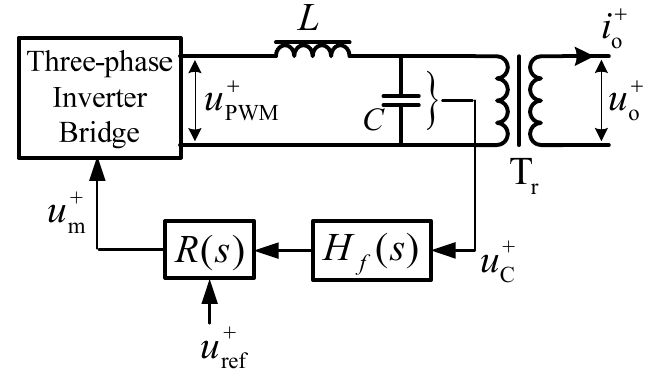
Figure 7. IPSC equivalent circuit for three-phase inverters with a PID controller.